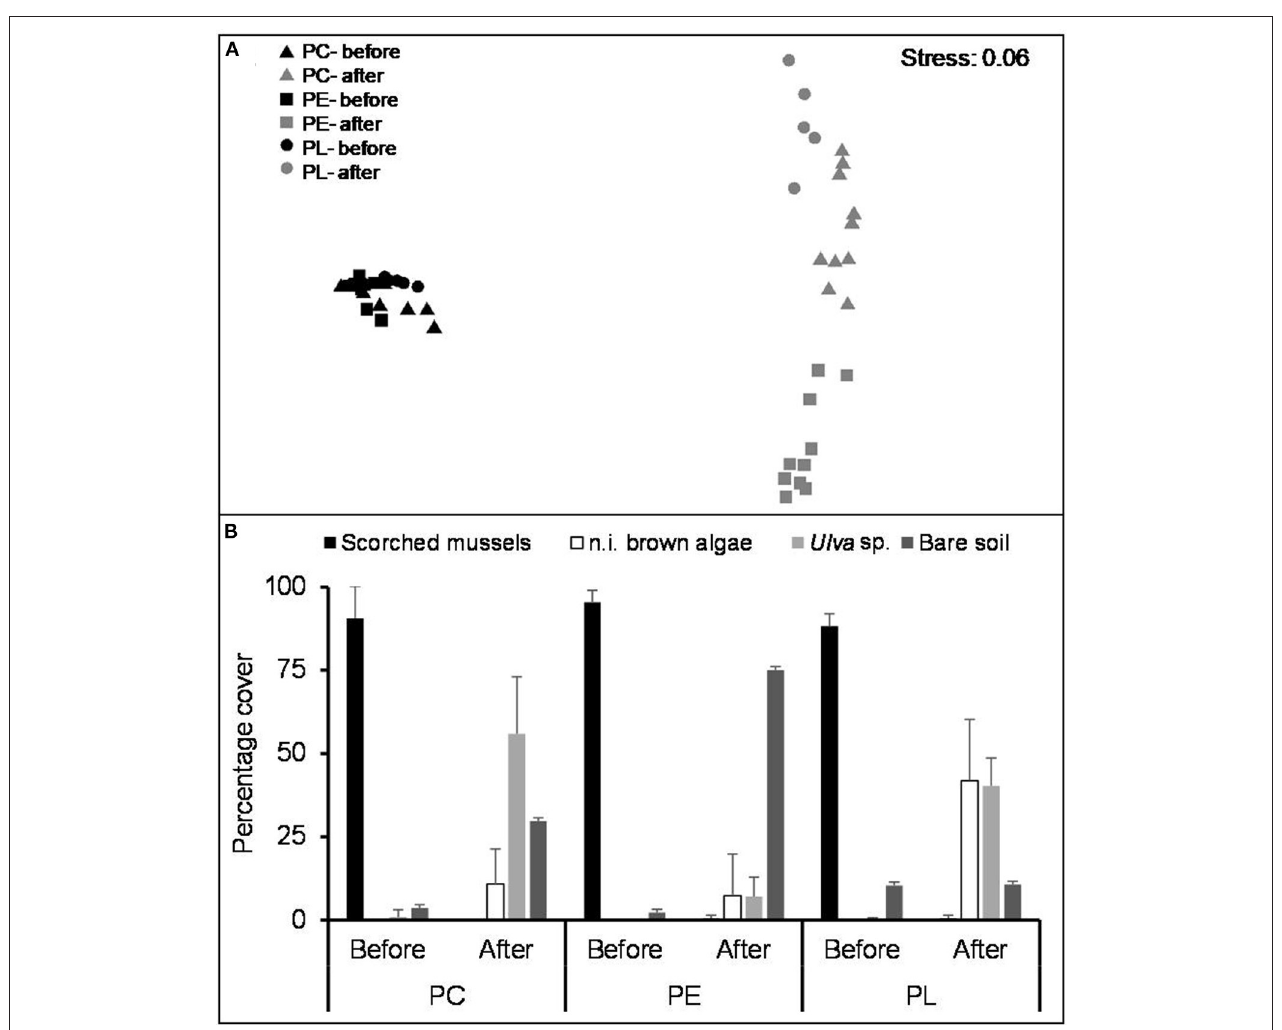
FIGURE 2 | (A) Two-dimensional MDS ordination comparing benthic assemblages associated with the three sites before and after the 2019 austral summer. (B) Mean (SD) scorched mussel, not identified (n.i.) brown algae, Ulva sp., and bare soil cover for the three samplings sites before and after the 2019 austral summer. These taxa explain > 90% of the observed differences in the assemblages between sampling times (SIMPER analysis, Table 1